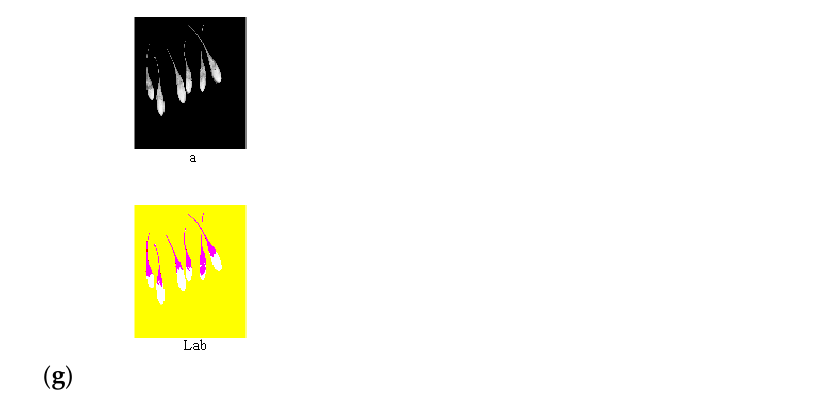
Figure 10. Original image ( a ), component S ( b ), binary processing ( c ), morphology processing ( d ), masks of RGB model ( e ), masks of HSV model ( f ), and masks of lab model ( g ) of the half-ripe fruit.